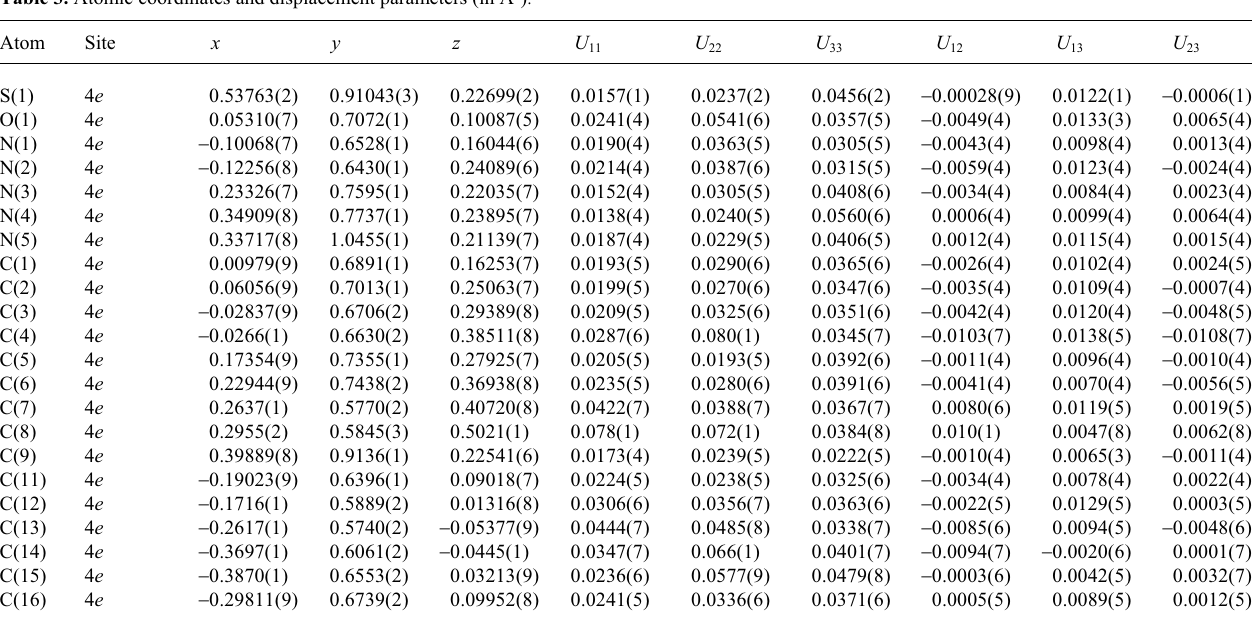
Table 3. Atomic coordinates and displacement parameters (in Å 2 )